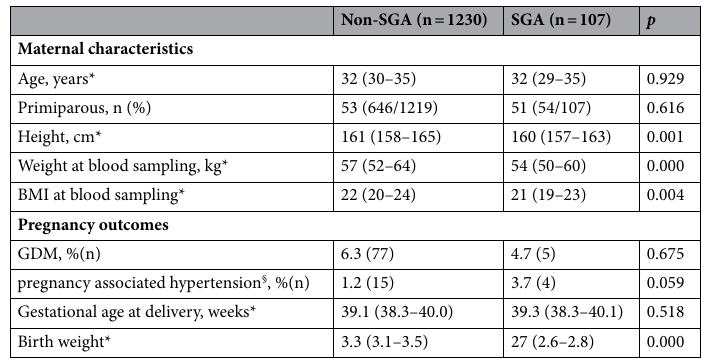
Table 1. Maternal characteristics and pregnancy outcomes of study population. BMI; body mass index, GDM; Gestational diabetes mellitus, SGA; small for gestational age. *All values were presented by median (interquartile ranges). § Includes gestational hypertension and